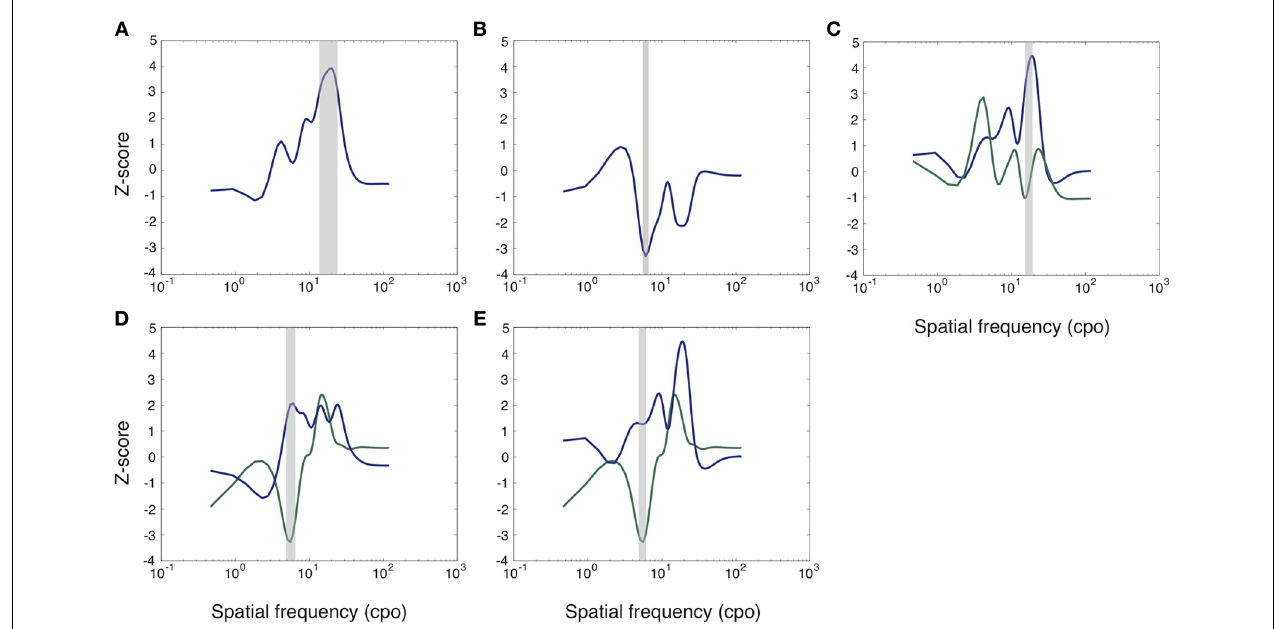
FIGURE 3 | Group classification vectors depicting the correlations between SFs and RTs for different conditions. Higher z-scores indicate a negative correlation (SFs leading to shorter RTs) while lower z-scores indicate a positive correlation (SFs leading to longer RTs). Highlighted gray areas are significant ( p < 0 . 05). See text for details. (A) All objects together. (B) The